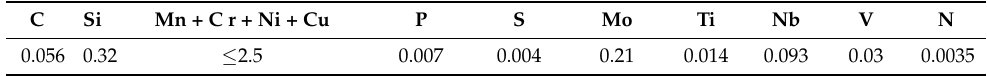
Table 1. Chemical composition of experimental steel